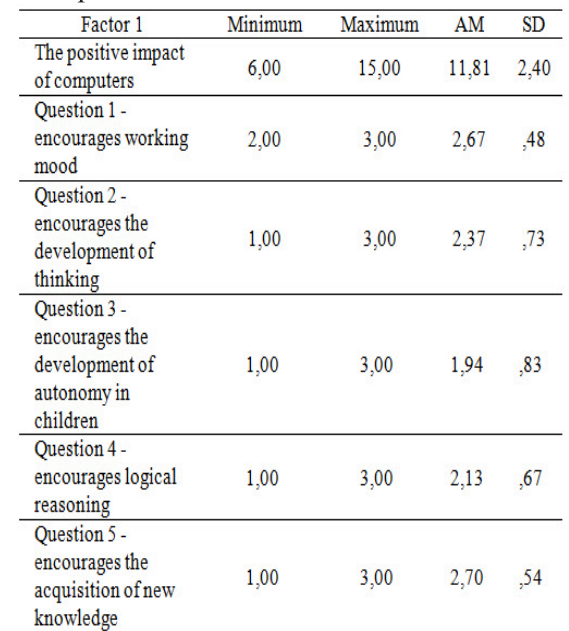
Table 5. Expressiveness of attitudeon